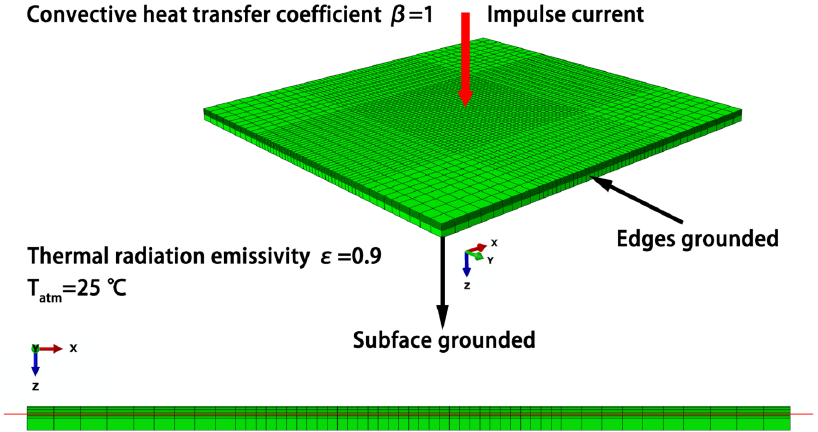
Figure 1. Schematic diagram of the composite lightning damage model. The red line represents the damage depth of 1.6 mm.